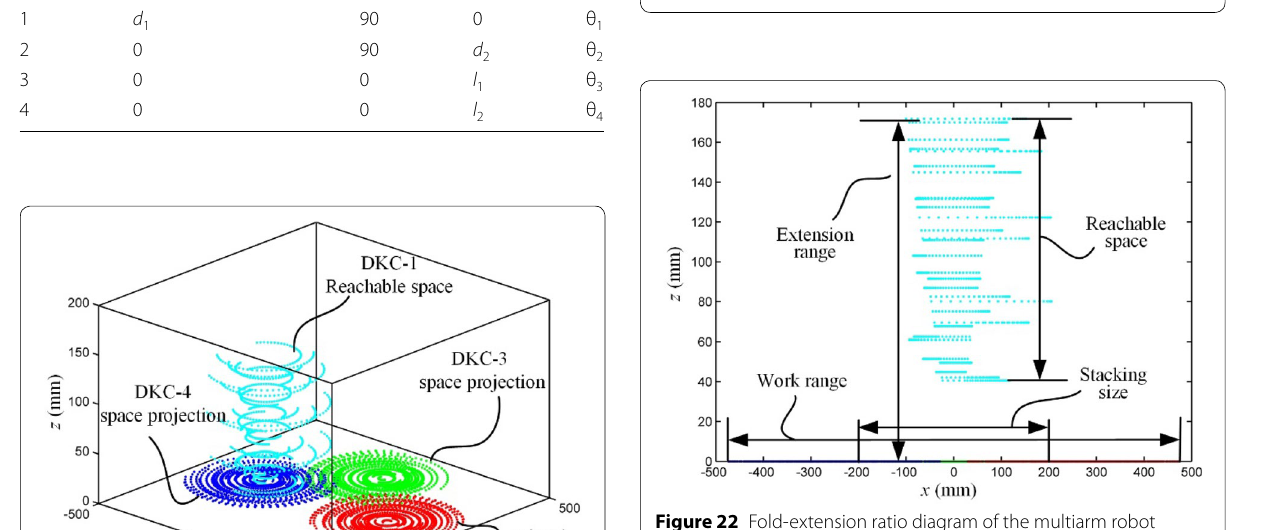
Figure 21 Top view of the reachable space projection